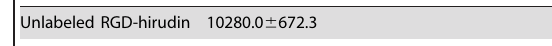
anti-thrombin activity (ATU/mg) Mean ± SD